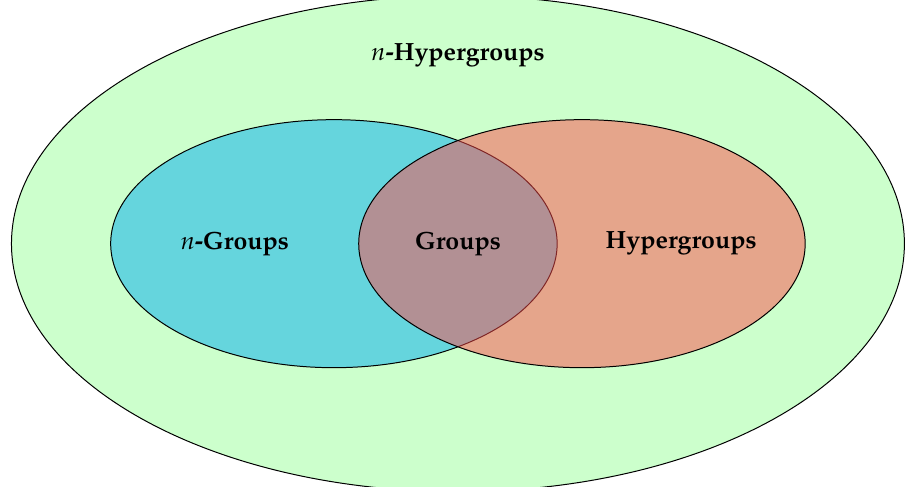
Figure 1. The connections between groups, n -groups, hypergroups, and n